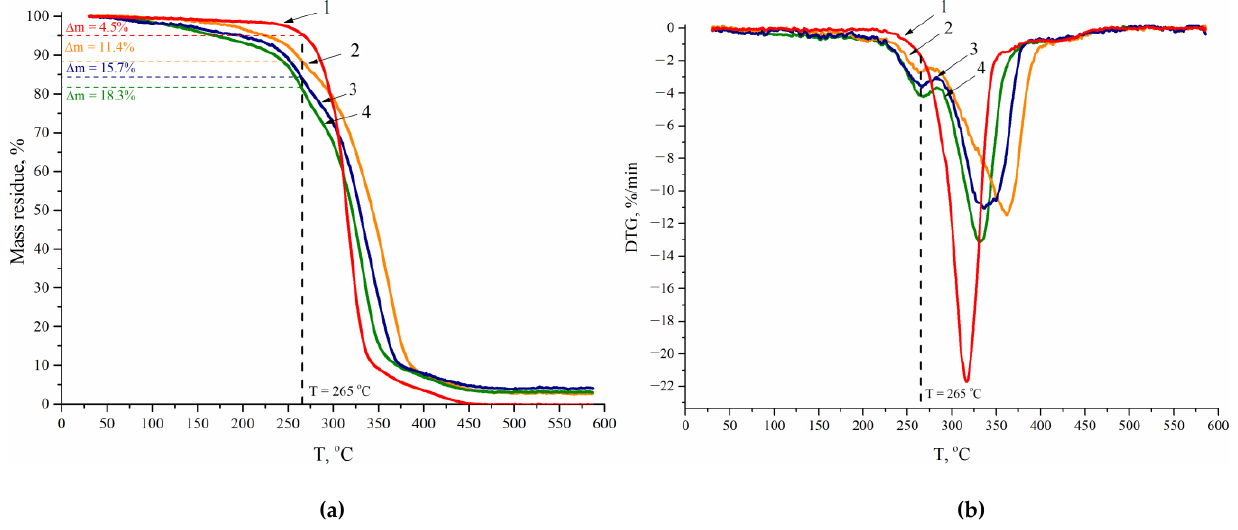
Figure 9. TGA ( a ) and DTGA ( b ) thermograms for WPU films: 1 — sample 2.1; 2 — sample 1.1; 3 — sample 1.4; 4 — sample